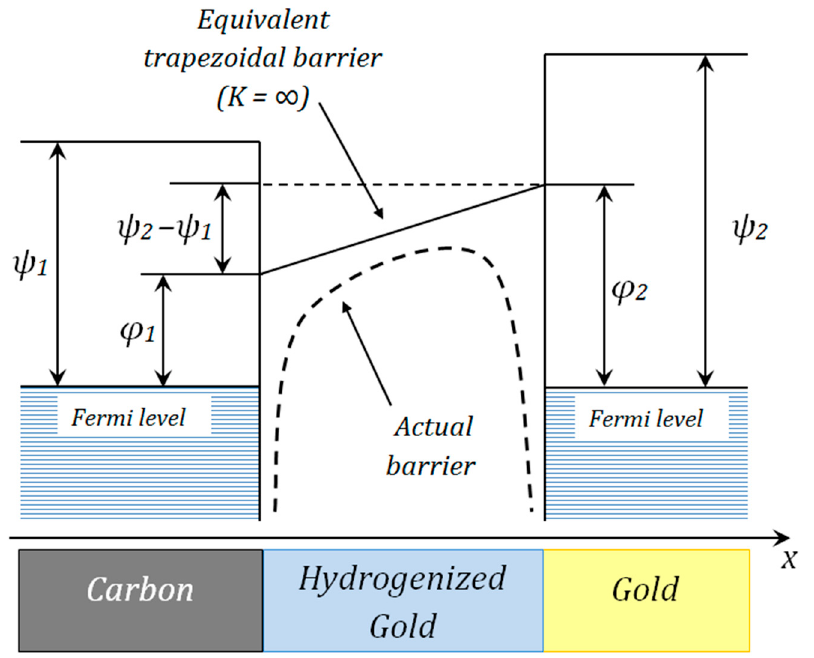
Figure 4. Energy diagram for gold and carbon electrodes separated by a semiconductor layer of hydrogenized gold.